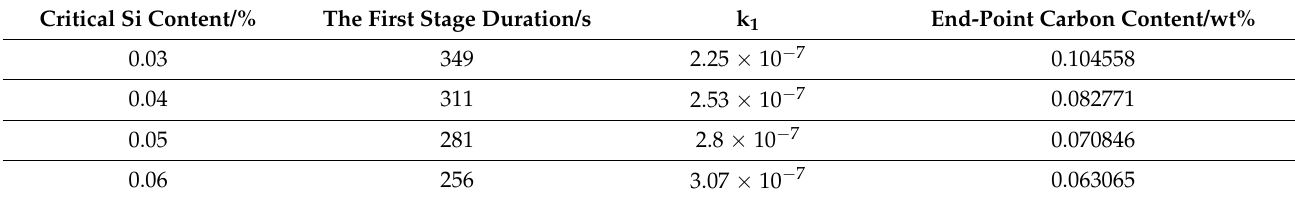
Table 2. The effect of critical silicon content on model performance.